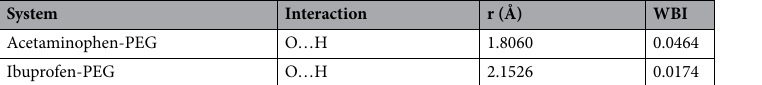
Table 7. The Wiberg bond order index (WBI), and the smallest interatomic distances ( r e (Å)) between of binary systems containing drugs and PEG.